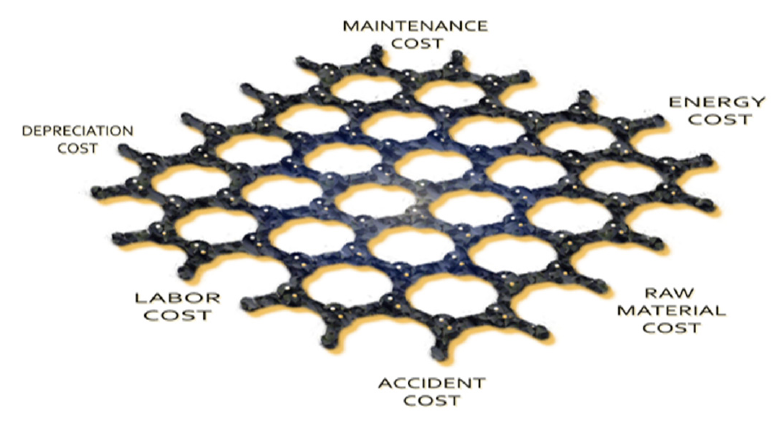
Figure 3. PIM membrane cost profile based on synthesis and characterization processes.